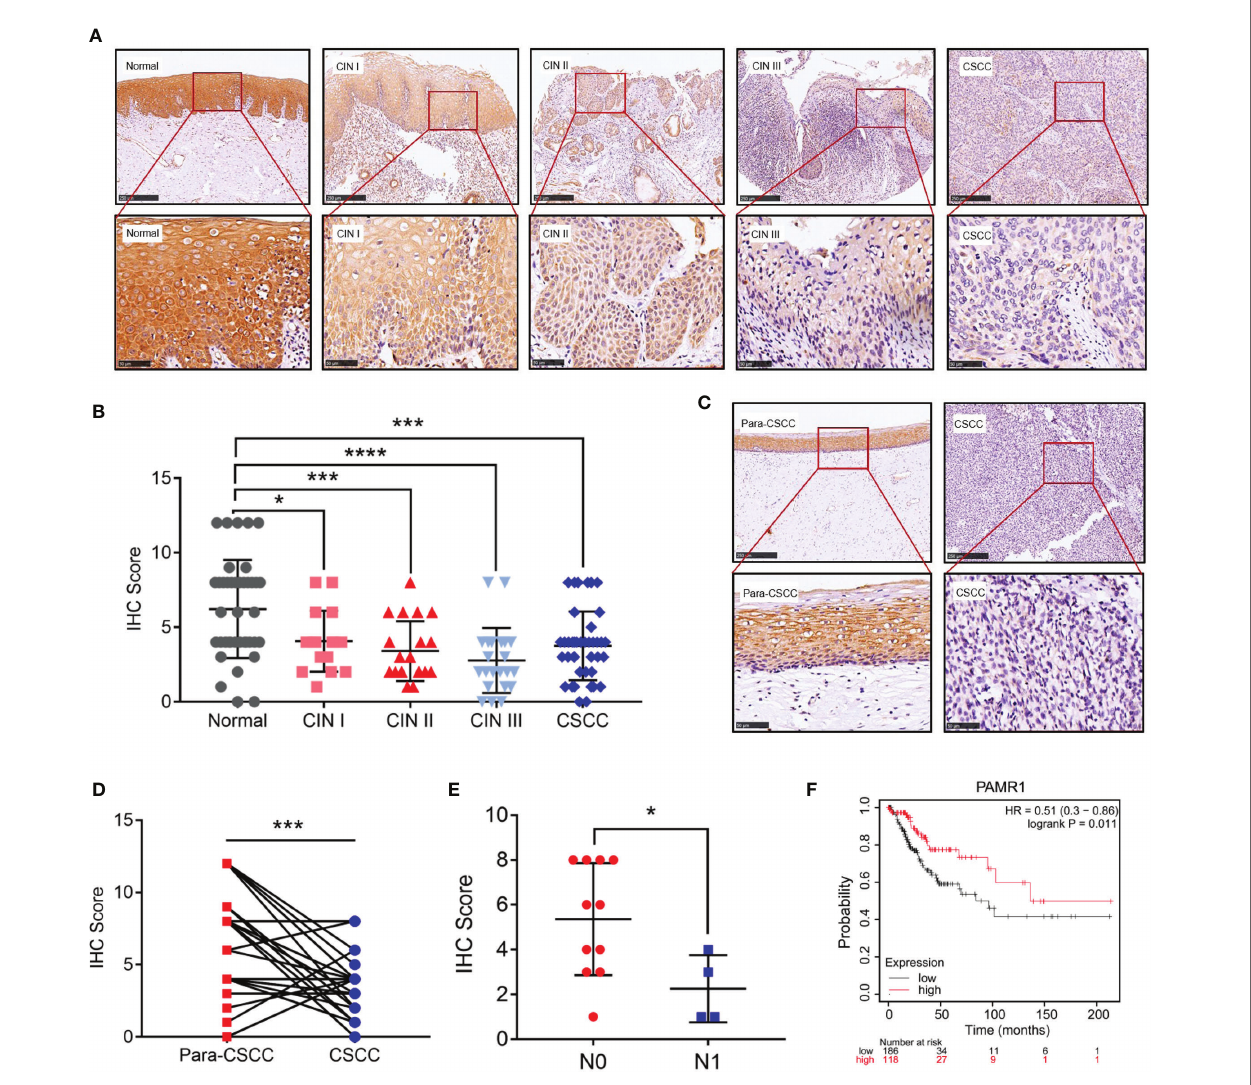
FIGURE 2 | The protein level of PAMR1 in cervical cancer. (A) The protein level of PAMR1 in normal cervical epithelial tissues, cervical intraepithelial neoplasia (CIN) and cervical cancer tissues detected by immunohistochemical (IHC) staining. (B) IHC scores between normal cervical epithelial tissues, CIN, and cervical cancer tissues. (C) The protein level of PAMR1 in cervical cancer tissues and adjacent normal epithelial tissues detected by IHC. (D) IHC scores between cervical cancer tissues and adjacent normal epithelial tissues. (E) PAMR1 IHC scores between N0 ( n = 11) and N1 ( n = 4) of cervical cancer samples. (F) Kaplan – Meier analysis of PAMR1 on overall survival (OS) of cervical cancer patients from Kaplan – Meier plotter (http://kmplot.com/analysis/). * p < 0.05, *** p < 0.0005, **** p <